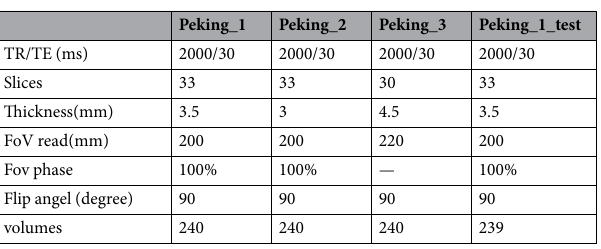
Table 7. Scan parameters for functional MRIs.